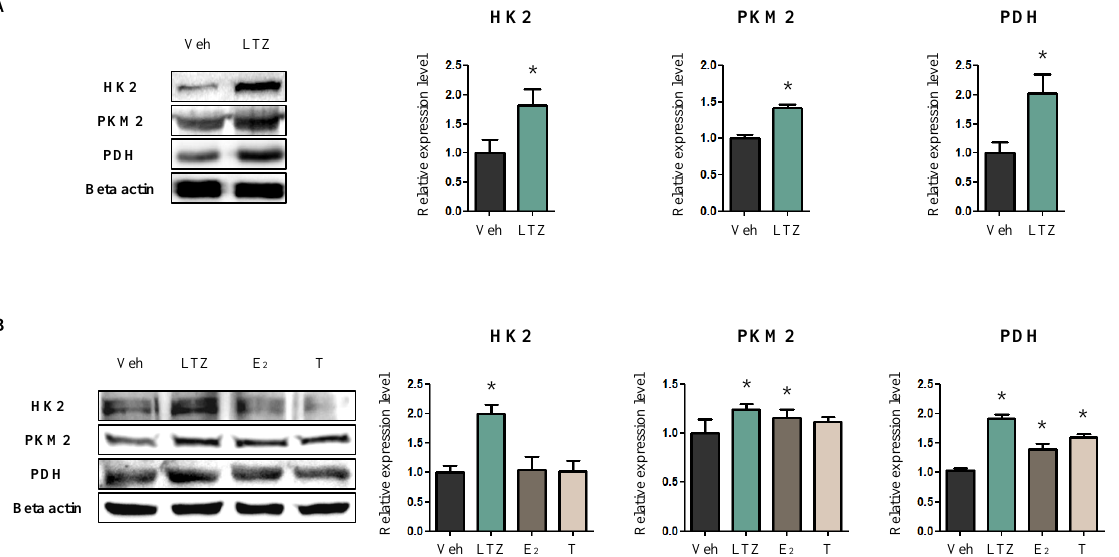
Figure 4. Letrozole increases glycolysis in cardiomyocytes. ( A ) The levels of proteins related to glycolysis were determined via Western blotting with LV tissues. Beta actin was used as internal control. ( B ) The levels of proteins related to glycolysis were determined via Western blotting with H9c2 cells. These cells were exposed to fatty acids (Palmitic acid 330 µ M, Oleic acid 660 µ M) and treated with LTZ, ethynylestradiol [E2] and testosterone [T], respectively. Beta actin was used as internal control. The values stand for means ± S.D. * p < 0.05 compared to Veh-rats or